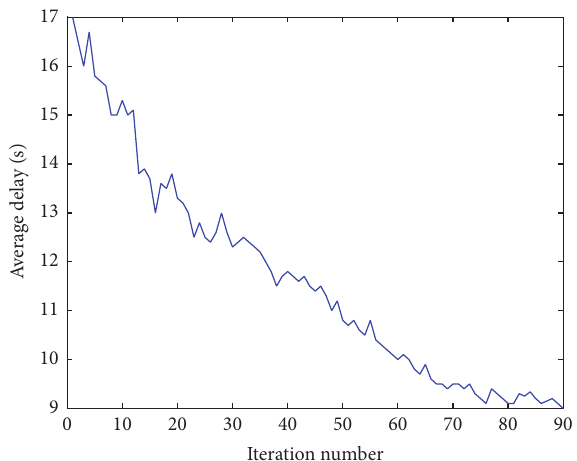
Figure 3: Convergence performance of SPSA